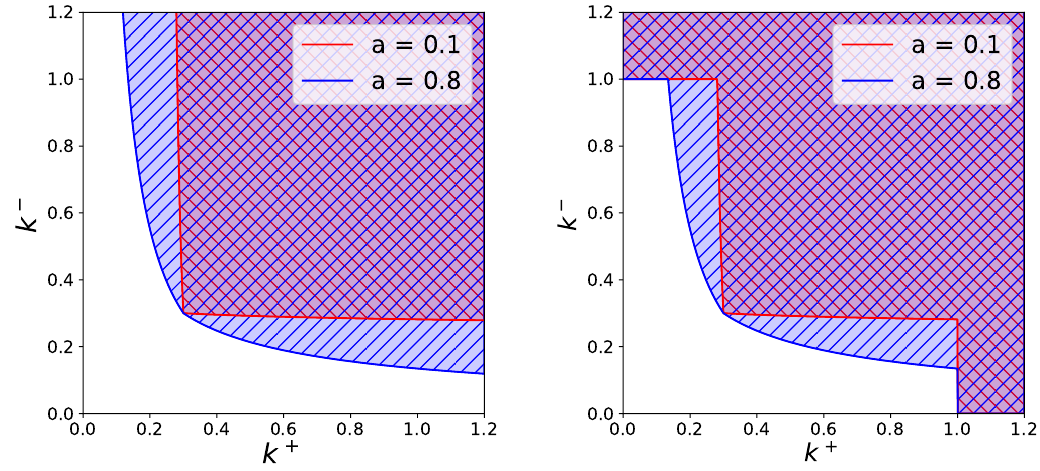
Figure 1 . Phase space diagram in the { k + , k − } plane. The phase space region where there is a virtual contribution but no real radiation is shaded, a = 0 . 1 (red) and a = 0 . 8 (blue). On the left we show the phase space region without the extra UV regulator, and on the right the region with the extra UV regulator which has been drawn as a hard cutoff k + . ν , k − . ν for illustrative